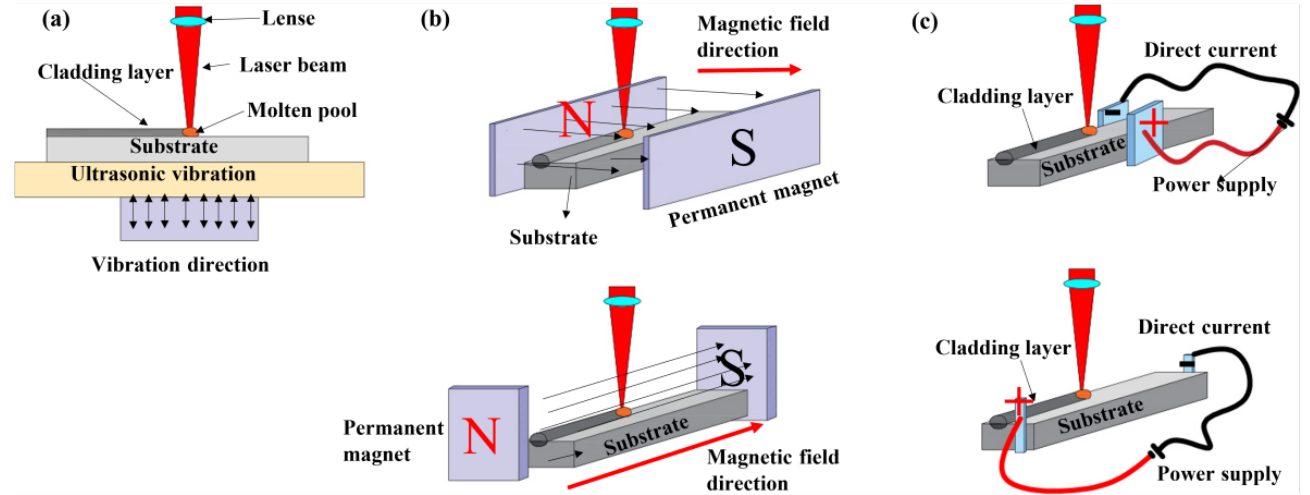
Figure 6. Schematic diagram of LC processing assisted with auxiliary technology: ( a ) ultrasonic vi- bration; ( b ) magnetic field treatment; ( c ) electric field treatment. vibration; ( b ) magnetic field treatment; ( c ) electric field